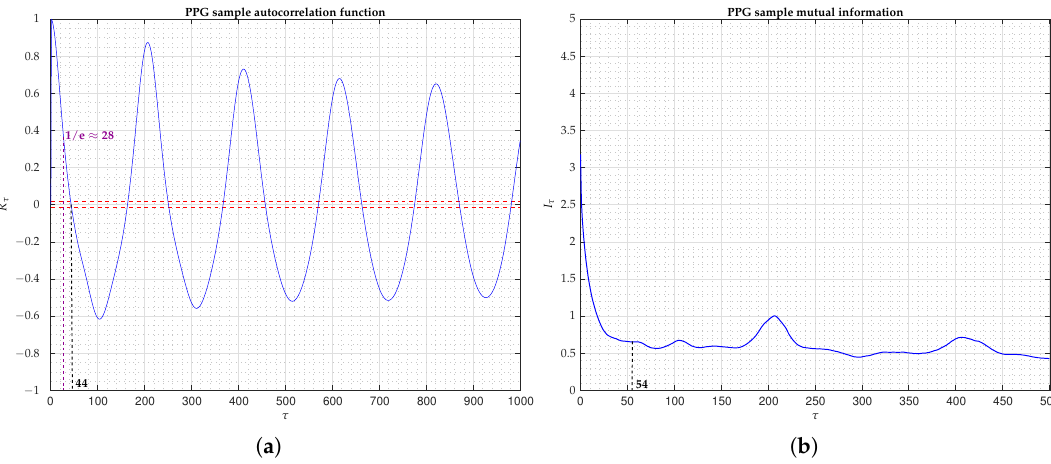
Figure 10. From a sample PPG signal (Subject Number 4): ( a ) autocorrelation function (AF), where the first zero crossing is when τ = 44; and ( b ) mutual information (MI), where the first minimum is with τ =